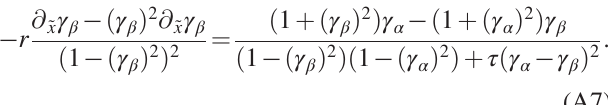
FIG. 6. Determination of the zero-temperature bulk gaps. (a) Normalized tunneling spectra as a function of the bias voltage. The symbols correspond to the experimental spectrum measured at 0.3 K deep inside the Pb island ( x ¼ − 80 nm). The solid line corresponds to the best fit obtained with the BCS theory for Δ 1 ¼ 1 . 2 meV and T ¼ 0 . 55 K. (b) The same as in the upper panel but for a spectrum measured in the Pb monolayer very far away from the island edge ( x ¼ þ 200 nm). The BCS tunneling spectrum was obtained using Δ 2 ¼ 0 . 23 meV and T ¼ 0 . 55